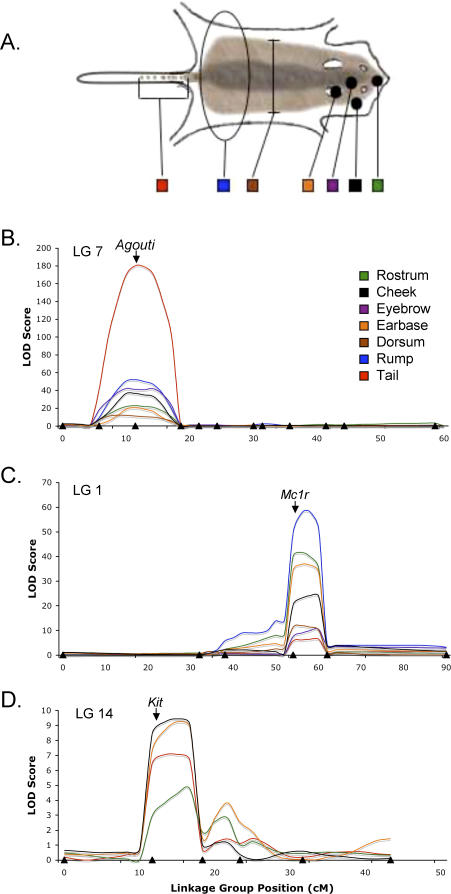
Genetic Architecture of Pigmentation in a Cross between Beach and Mainland Subspecies(A) Each of seven pigmentation traits for which we found significant QTLs is highlighted in a different color on a cartoon of a mouse pelt. MQM analyses showed that two LGs harbored major effect QTLs and one LG carried a minor effect QTL. For each LG, LOD scores are shown as a function of genetic distance in centimorgans (cM). Black triangles on x-axes show the position of marker loci. Each line indicates the LOD score at 5-cM intervals along the LG and are coded by colors corresponding to each of the seven traits.(B) One region of major affect maps to LG 7 and the Agouti locus maps to the peak in LOD score.(C) A second major-effect region is located on LG 1, and the Mc1r locus maps to the peak in LOD score. Both major-effect loci are statistically associated with all seven pigmentation traits studied.(D) A QTL of minor effect is located in LG 14, and the Kit locus maps near the peak. This minor effect locus is associated with four of the seven pigmentation traits.